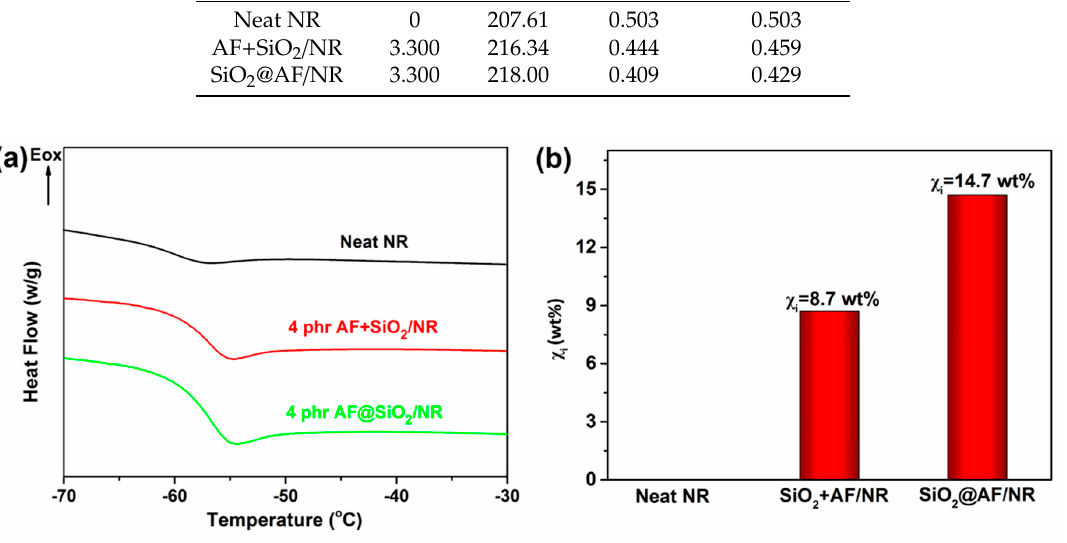
Figure 6. ( a ) DSC curves of the neat NR and the SiO 2 + AF / NR and SiO 2 @AF / NR composites. ( b ) Weight fraction of the immobilized NR chains in the composites.